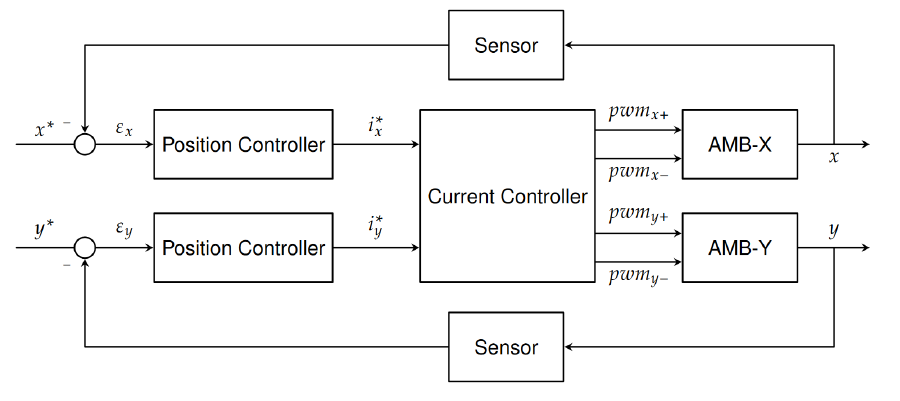
Figure 6. Block diagram of the overall control loop for one bearing, adopted from